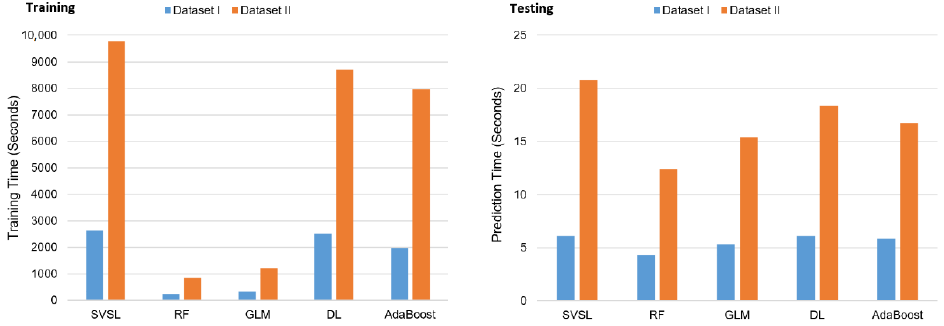
Figure 12. Training and testing times for all the methods in